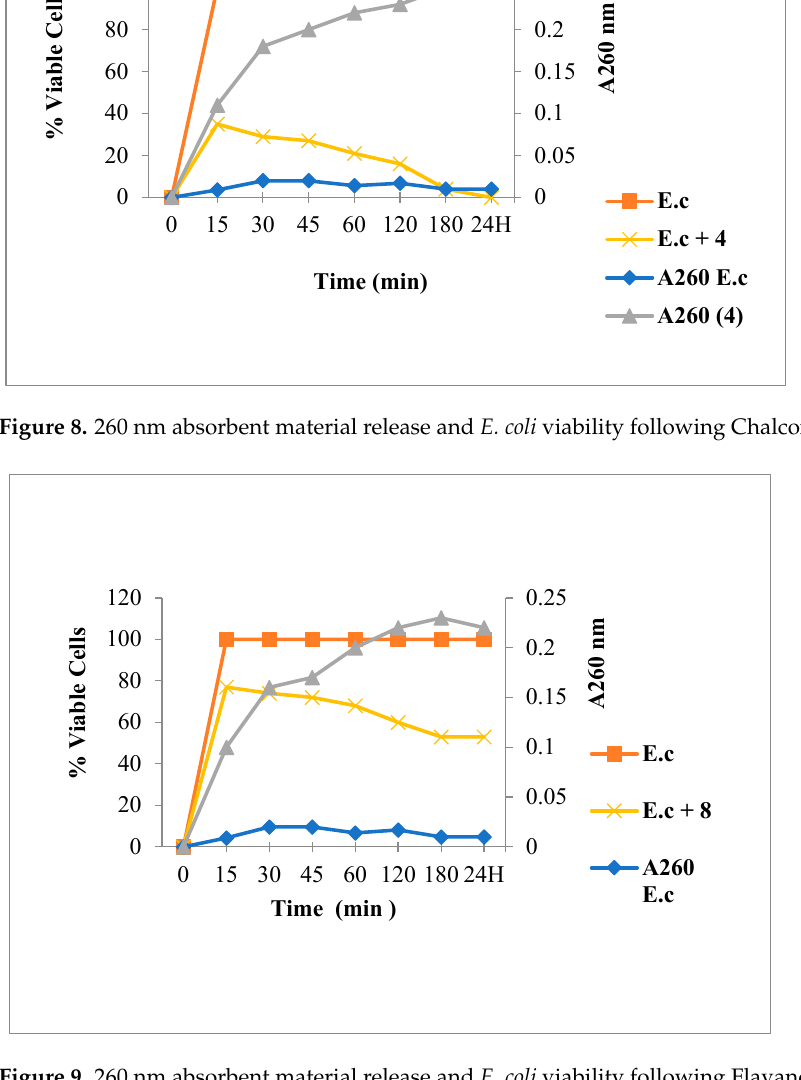
Figure 9. 260 nm absorbent material release and E. coli viability following Flavanone 8 treatment.